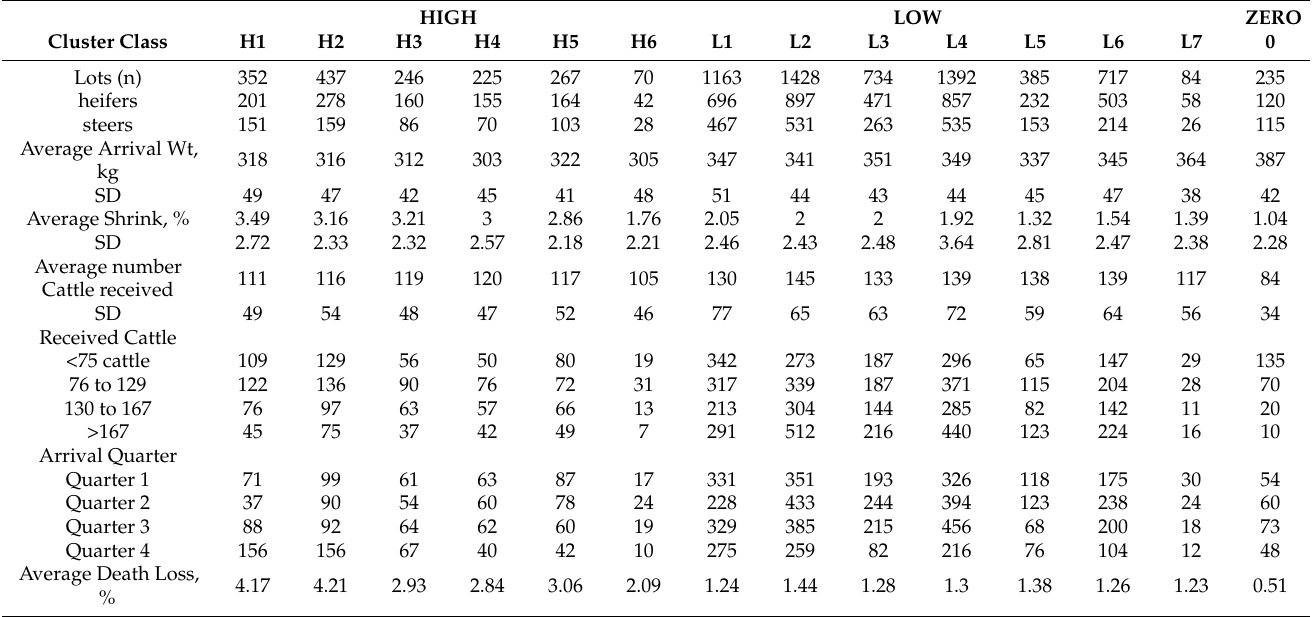
Figure 4. Data from 10 US feedlots were used to perform a cluster analysis of cohorts with >0 to <15% bovine respiratory disease (BRD) morbidity based on the cumulative timing, days on feed (DOF). Cohorts were placed in clusters based on morbidity timing (or in the case of ZERO, the lack of BRD morbidity). Table 1 shows the descriptive statistics of cohorts within clustering groups and by factors of interest. Table 1. Descriptive statistics of HIGH, LOW, and ZERO cumulative bovine respiratory disease morbidity clusters and risk factors. Data from 10 US commercial feedlots were used to analyze hierarchical clustering of cumulative distributions of first treatment BRD in HIGH ( ≥ 15%) LOW (<15%) or ZERO (0%)